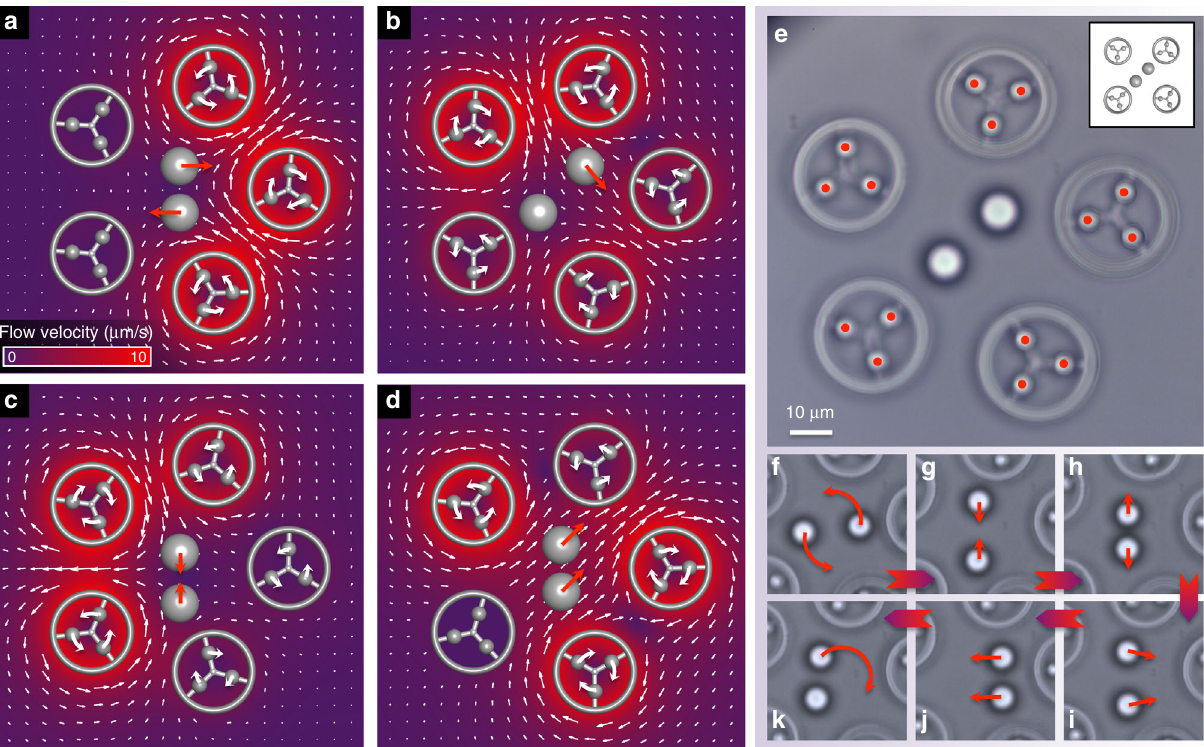
Fig. 5 Control of multiple particles simultaneously. Five micro-rotors arranged in a ring can be used to control four target degrees of freedom in two dimensions (2D). a – d Simulations of rotor actuation to push the targets in a variety of directions. In order to move the targets in opposite directions, a , c require the generation of a fl ow stagnation point between the targets. In b , the lower left target is held stationary by creating a fl ow stagnation point at its location, while the upper right target is translated. In d no fl ow stagnation point is necessary as both targets are moved in the same direction. Each case shows the optimum combination of rotor motions to achieve the required target translations. We note that with this many degrees of freedom, it is sometimes not an intuitive result. e Optical image of the experimental fi ve rotor set-up. Inset shows a schematic of a four rotor set-up. In this case, there is no way the rotors can be spun to push the targets together. f – k Snapshots from Supplementary Video 9 zoomed in on the central region, showing